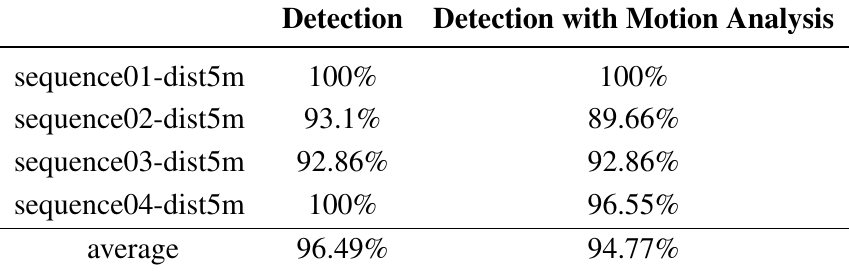
Table 4. Mean value of correct first detections at distances up to 5